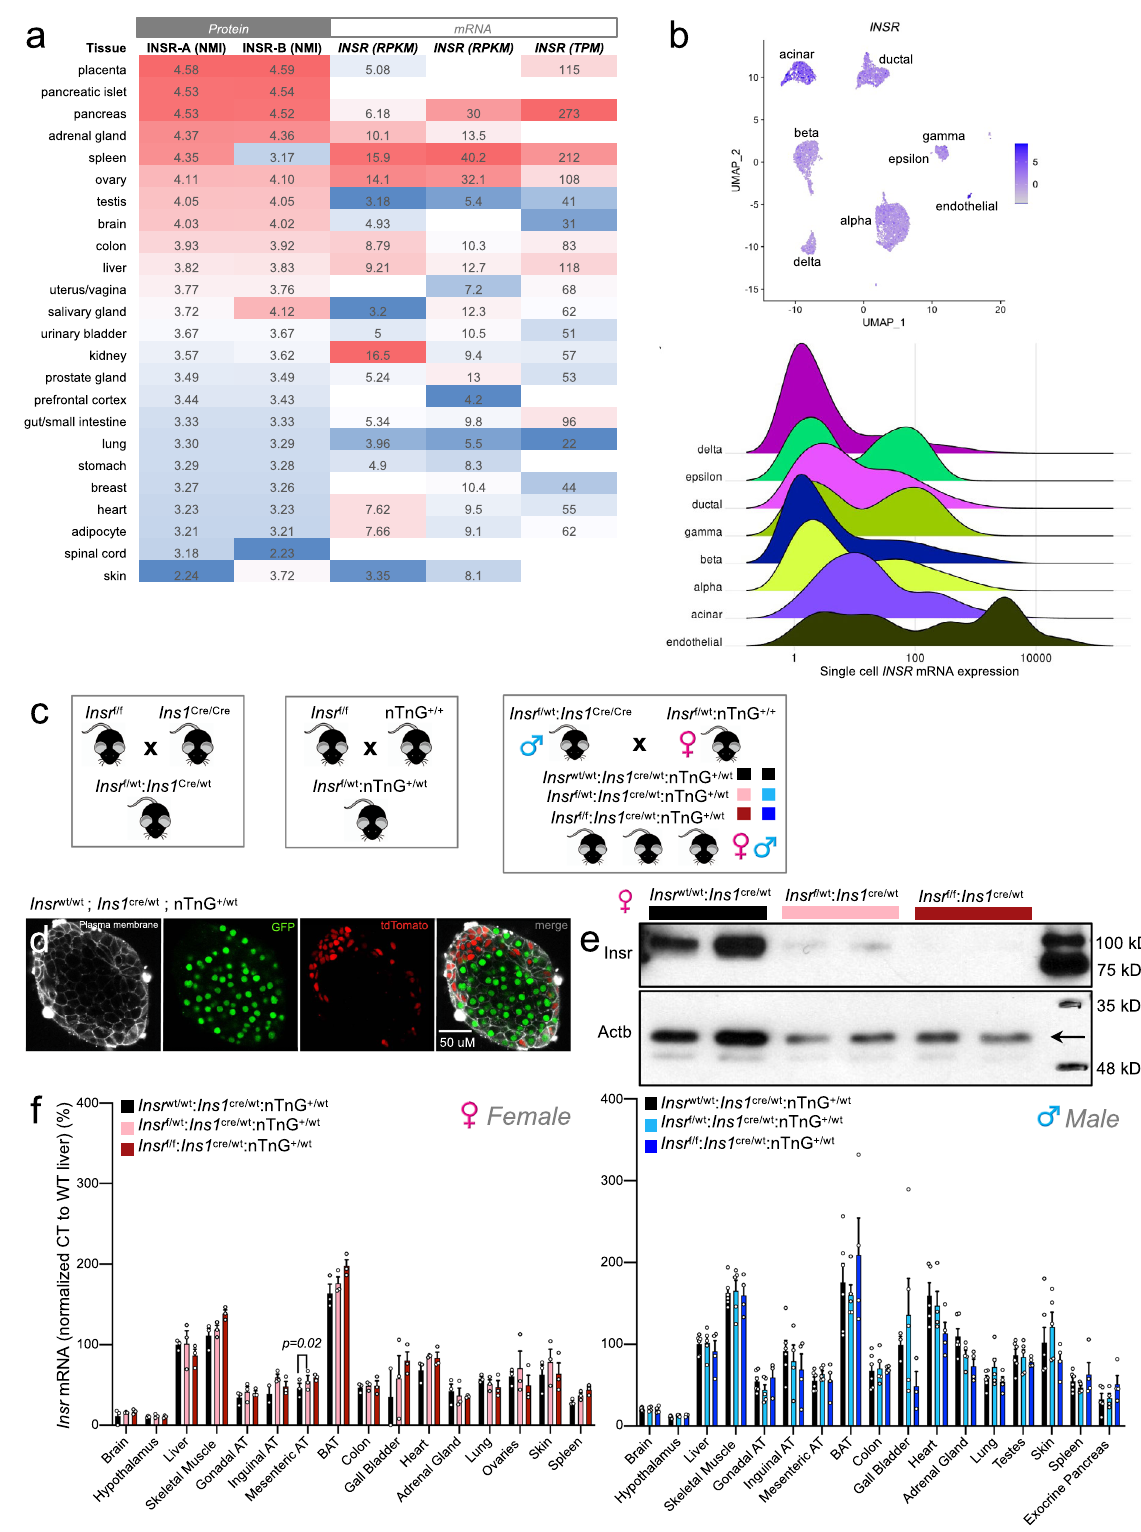
sexes, these data highlight the importance of considering both sexes separately. Loss of β -cell Insr increases β -cell excitability . Insulin admin- istration has been reported to open β -cell K ATP channels, med- iating negative feedback on insulin secretion 33 . Lack of